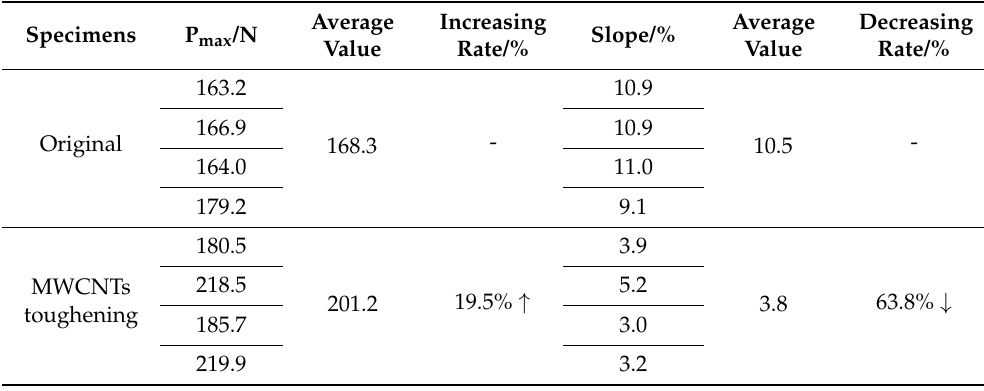
value of P max increased by 19.5% and the slope of nonlinear decrease stage decreased by 63.8%, compared with the original specimens. Table 2. The maximum loads and nonlinear decreasing slopes of the original specimens and the MWCNTs toughening specimens.